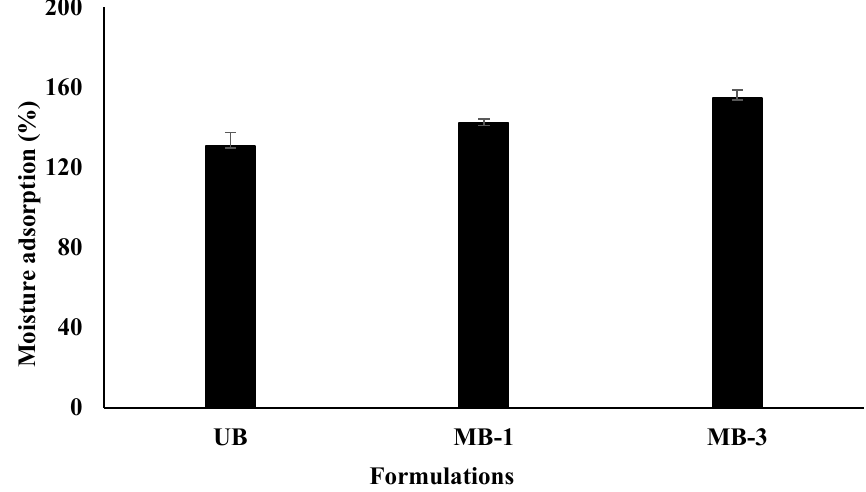
Figure 1. Percentage moisture adsorption of blended film formulations.